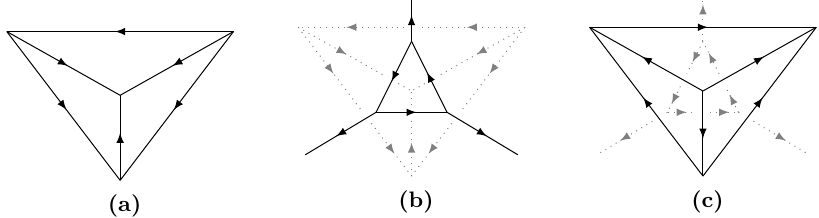
Figure 8 . For the triangulation Γ in (a), we define the dual graph ˜Γ in (b) in which the direction of each dual edge is a π/ 2 clockwise rotation of the corresponding edge in Γ . The double dual graph ˜˜Γ in (c), obtained as the dual graph of ˜Γ , is the same as Γ but with all edge directions